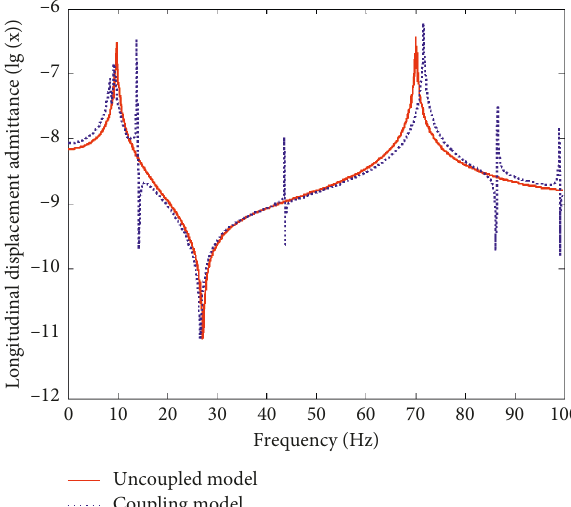
Figure 12: Longitudinal displacement admittance of thrust bearing with coupled effect or not.